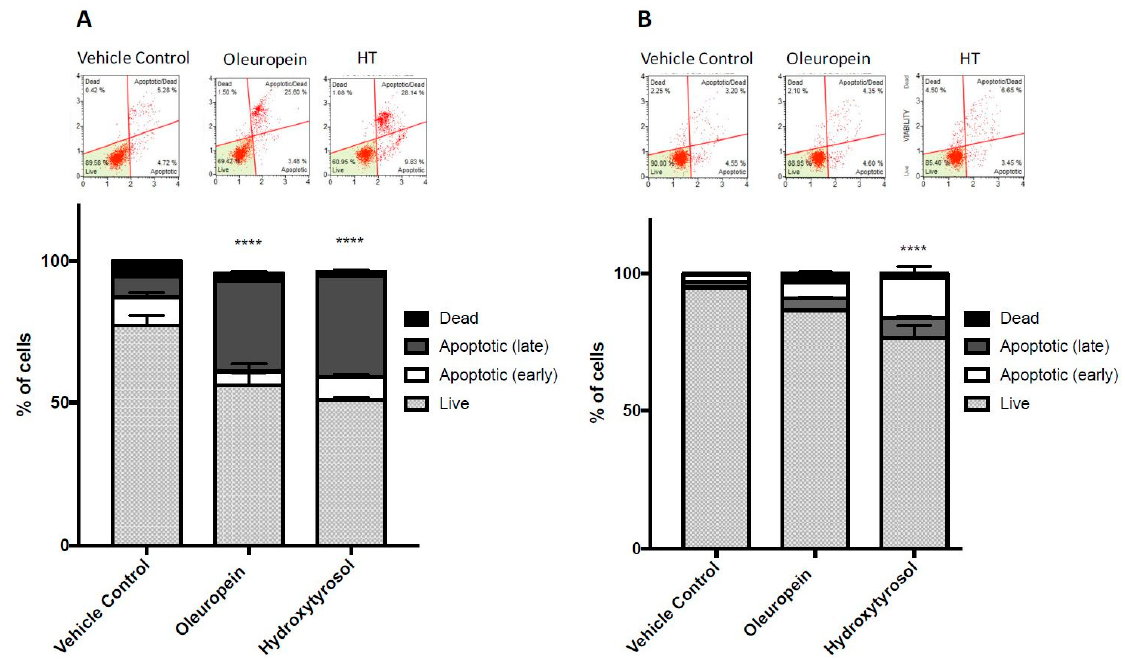
Figure 4. Induction of caspase 3/7-dependent apoptosis of MIA PaCa-2 ( A ) and HPDE ( B ) cells treated with oleuropein (200 µM) and hydroxytyrosol (100 µM) for 48 h. Bar graphs show the percentage of live, early apoptotic, late apoptotic and dead cells determined by analysis of the activation of caspase 3/7. Ordinary two-way ANOVA and Tukey’s multiple comparisons test compare total apoptotic cells in treated cells (oleuropein or hydroxytyrosol) to vehicle control. **** p < 0.0001.